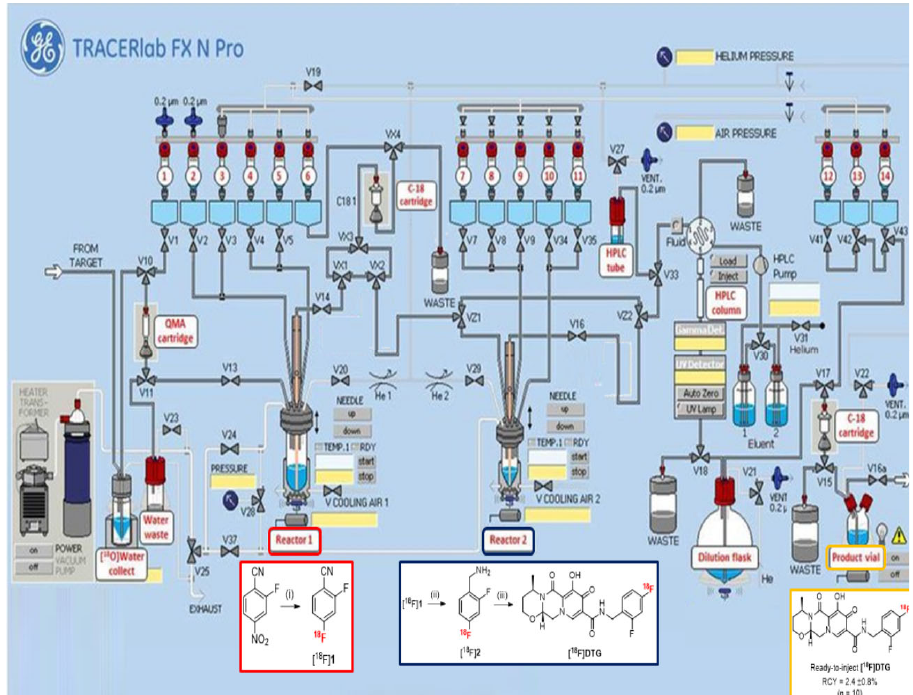
Figure 1. Automated radiosynthesis of [ 18 F]DTG on a TRACERlab ® FX N Pro module. Radiofluorination (red square) takes place in reactor 1, whereas the nitrile reduction and peptide coupling reactions (blue square) take place in reactor 2. Ready-to-inject [ 18 F]DTG (orange square) is obtained after semi-preparative HPLC purification and SPE formulation. Reagents and conditions: (i) K [ 18 F]F, K 222 , K 2 CO 3 , DMSO, 95 °C, 5 min; (ii) NaBH 4 2M (20 μ L), NiCl 2 ∙ 6H 2 O (25 mg), MeOH, H 2 O (100 μ L), r.t., 5 min; (iii) 3 , TBTU, DIPEA, DMF, r.t., 10 min.